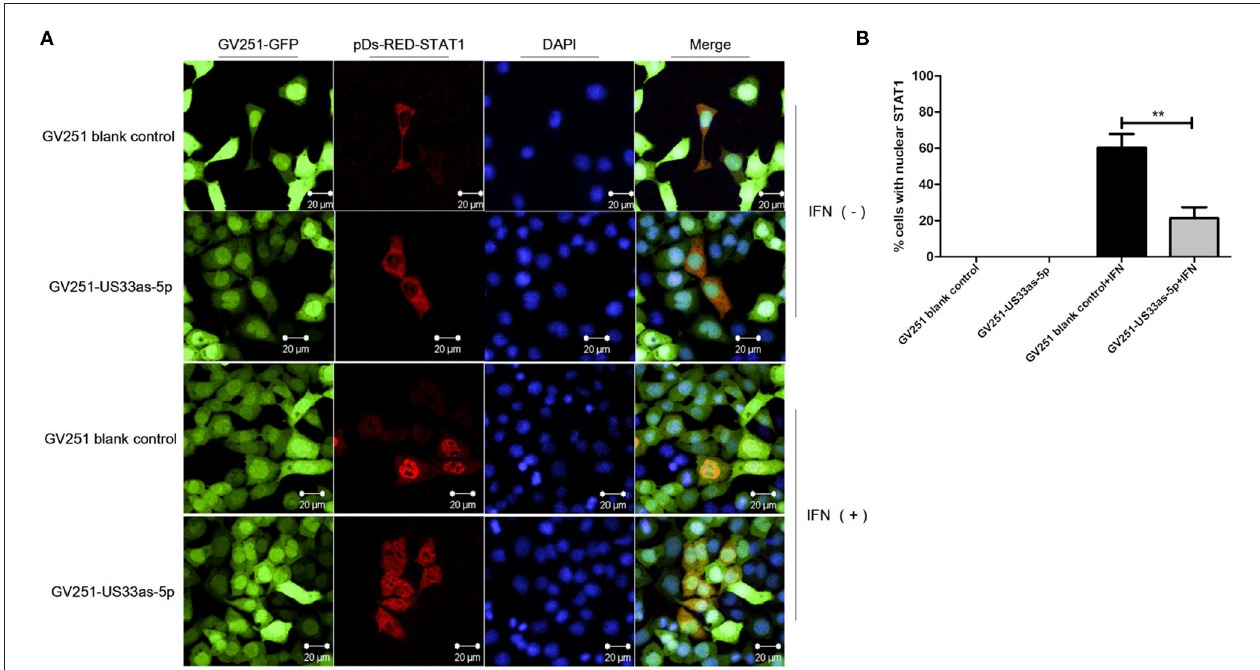
FIGURE 4 | hcmv-miR-US33as-5p inhibits the nuclear translocation of STAT1. (A) 293 cells were transfected with GV251 blank vector or vector containing US33as-5p, followed by selection with G418 (0.5 µ g/mL) for 3 days. The cells were then transfected with the pDs-RED-STAT1 vector for 24h and then stimulated with or without IFN α (1,500 IU/mL) for 12h. STAT1 nuclear localization was detected by indirect immunofluorescence. (B) Percentage of cells with nuclear STAT1 from experiments performed in A. Cells were counted in three random fields and the results are expressed as mean ± SD (** p < 0.01). Fluorescence was visualized with an Olympus FluoView 1000 confocal microscope. All images were captured under a 60 × objective